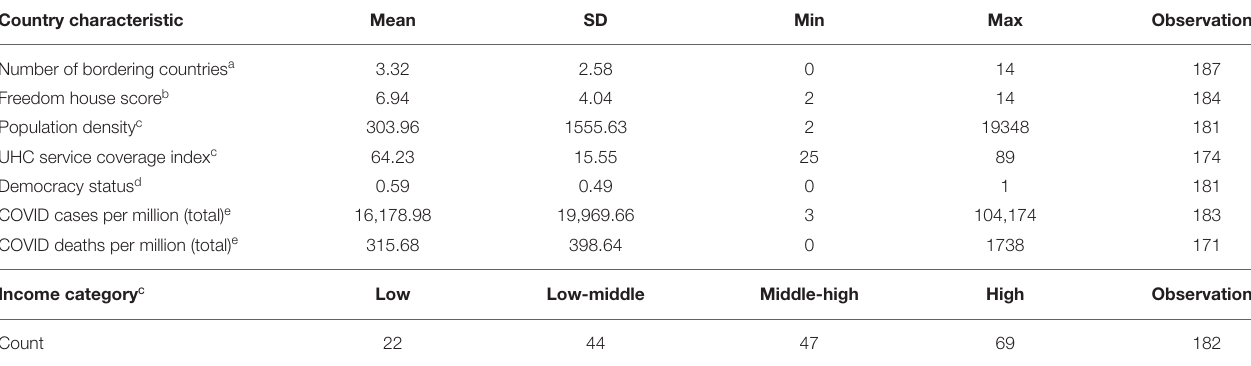
TABLE 1 | Summary statistics for country characteristics and COVID-19 outcomes. Country